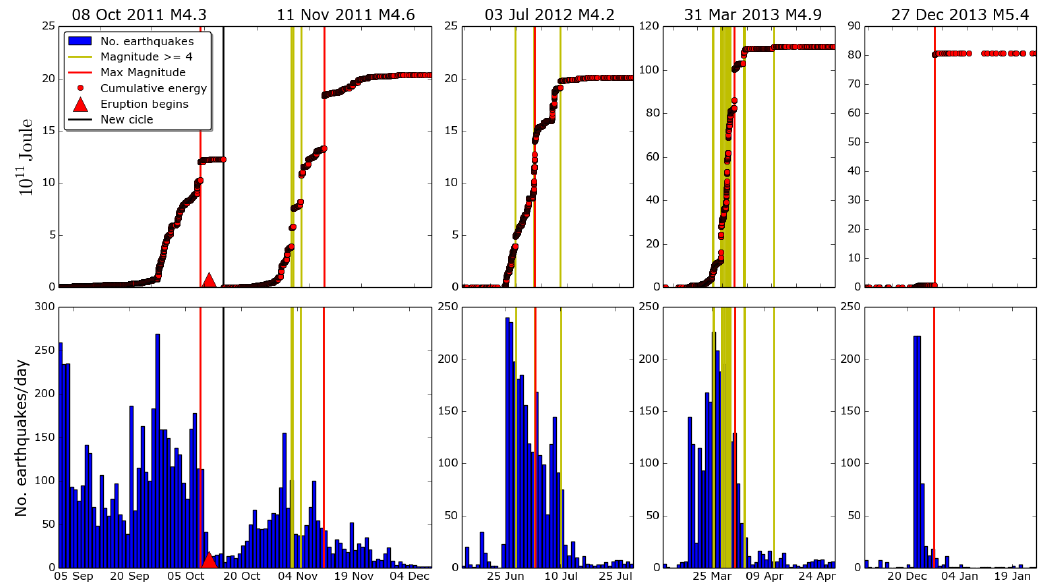
Figure 4. Seismo-volcanic crises identified at El Hierro island (2011–2014). The upper plots show the evolution of seismic energy for each of the cycles of unrest. The lower plots show the daily event count. The plots illustrate how the seismic activity drops rapidly after the largest magnitude earthquakes. Particularly significant is the absence of aftershocks after the largest (M5.4) earthquake of 27 December 2013. Data are from IGN public earthquake catalogue and the IGEO-CSIC seismic research network.